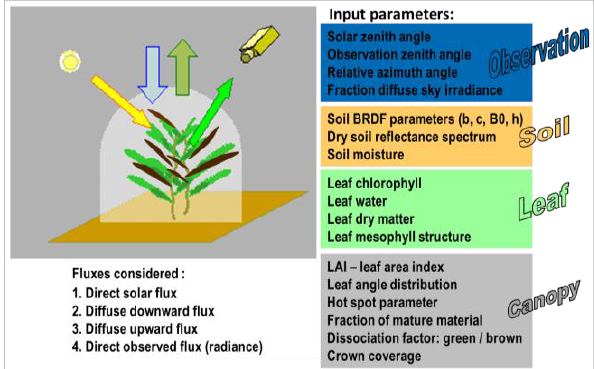
Figure 2: The SLC model and its input parameters [Verhoef & Bach 2003,